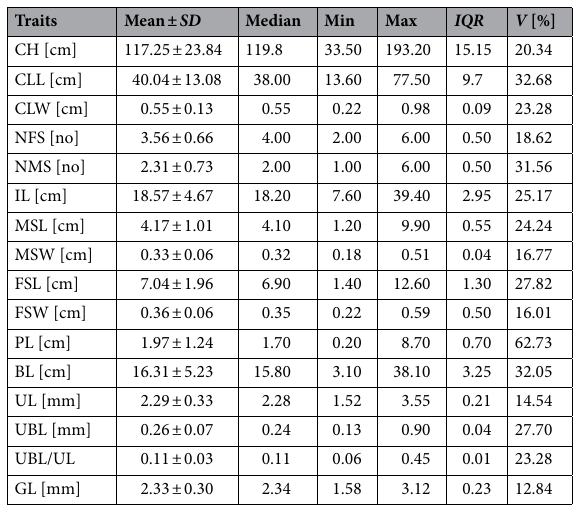
Table 2. Morphological traits of Carex buekii . SD, standard deviation; Min, minimum value; Max, maximum value; IQR, interquartile range; V, coefficient of